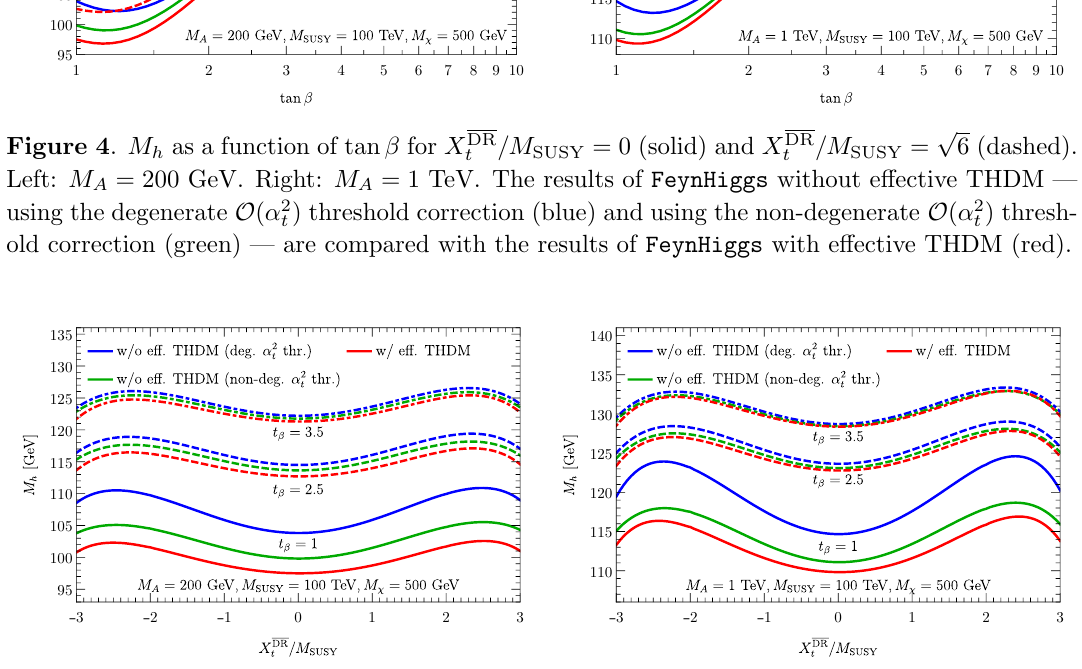
Figure 5 . M h as a function of X DR =M SUSY for tan (cid:12) = 1, (solid) tan (cid:12) = 2 : 5 (dashed), and t tan (cid:12) = 3 : 5 (dotdashed). Left: M A = 200 GeV. Right: M A = 1 TeV. The results of FeynHiggs without e(cid:11)ective THDM | using the degenerate O ( (cid:11) 2 ) threshold correction (blue) and using the t non-degenerate O ( (cid:11) 2 ) threshold correction (green) | are compared with the results of FeynHiggs t with e(cid:11)ective THDM